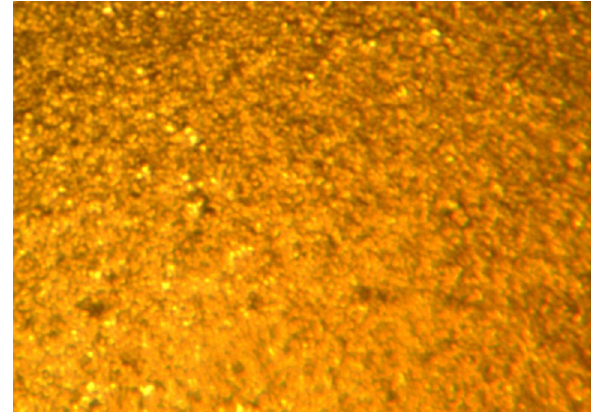
Figure 5 Microstructure of a combined detoxicant from beet pulp (400× magnification)